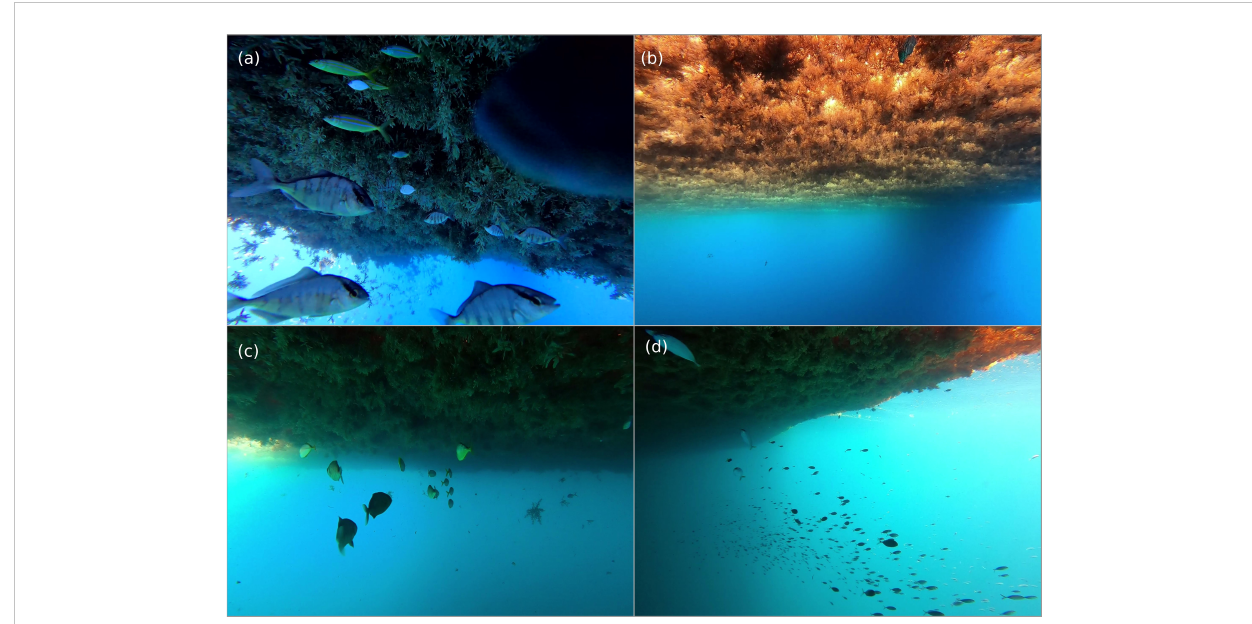
FIGURE 3 Still images collected from underwater videos of pelagic sargassum rafts. Smaller rafts (A) (5 m in diameter) and (B) (7 m in diameter). Larger rafts (C) (20 m in diameter) and (D) (100 m in